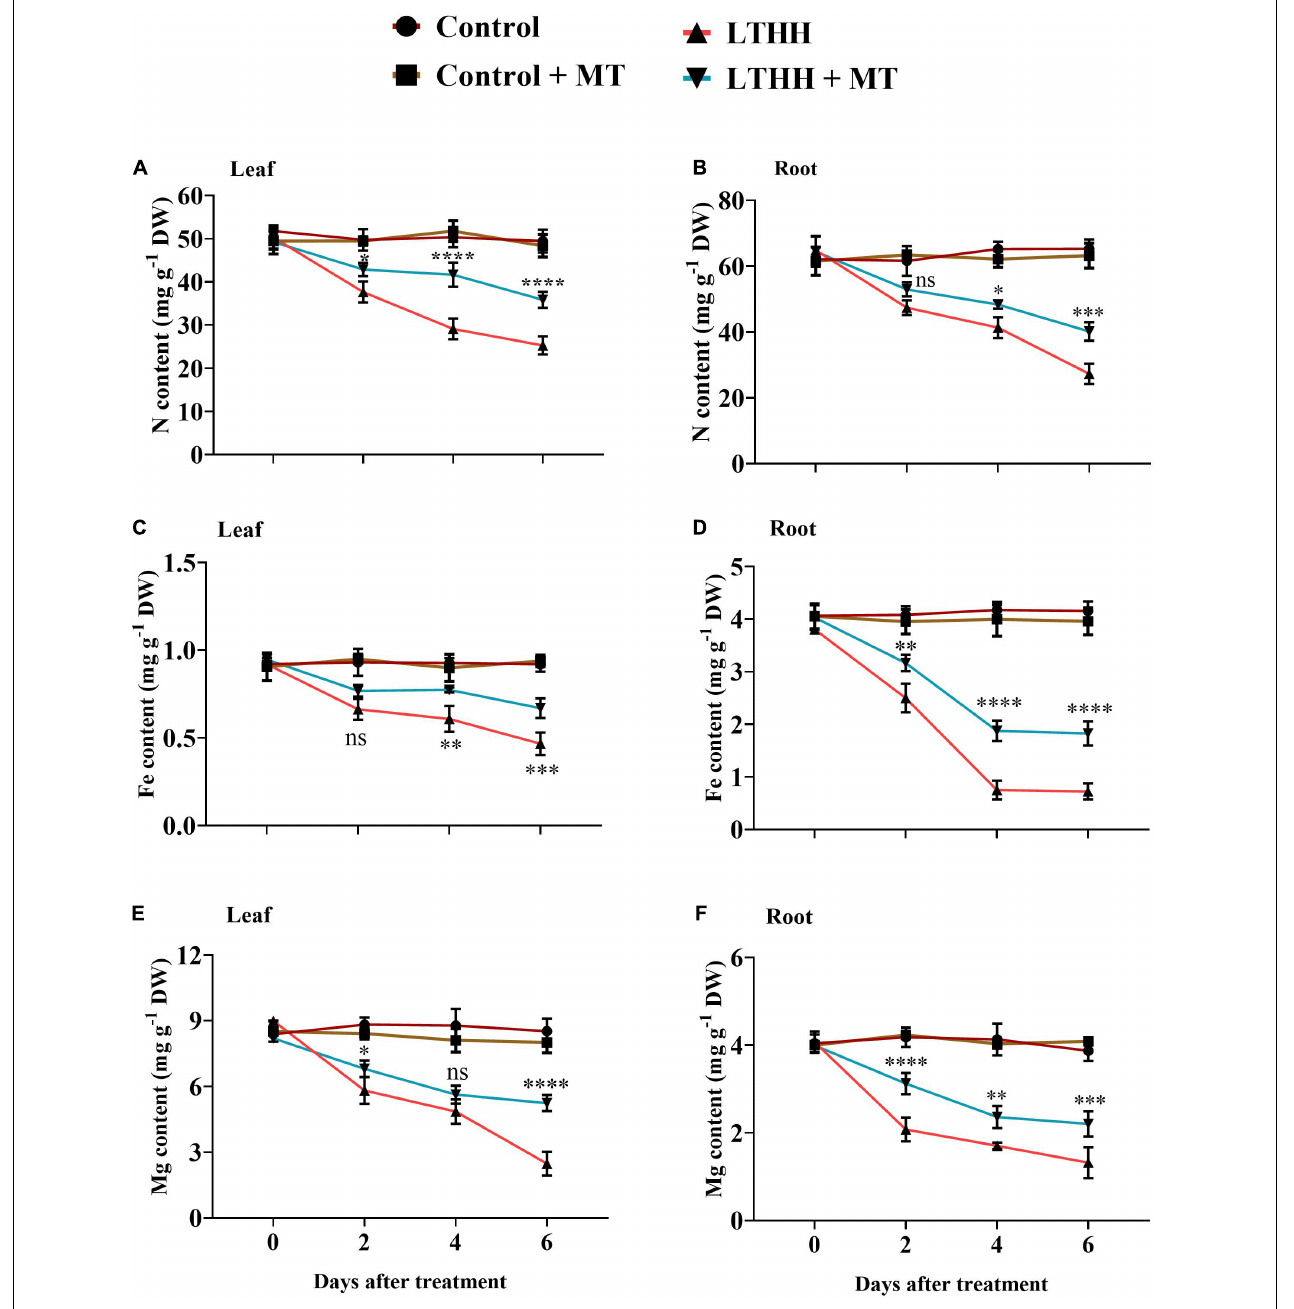
FIGURE 7 | Effect of exogenous melatonin on nitrogen content (A,B) , iron content (C,D) , and magnesium content (E,F) , in root and leaves of cucumber seedling under low-temperature and high-humidity stress. Control (25/18 ◦ C); Control + MT (200 µ M melatonin, 25/18 ◦ C); LTHH (15/10 ◦ C, 95%); LTHH + MT (200 µ M melatonin, 15/10 ◦ C, 95%). Results were presented as means ± SD ( n = 3), significance values were presented as: * P < 0.05; ** P < 0.01; *** P < 0.001; **** P < 0.0001; while non-significant (ns) ( P >